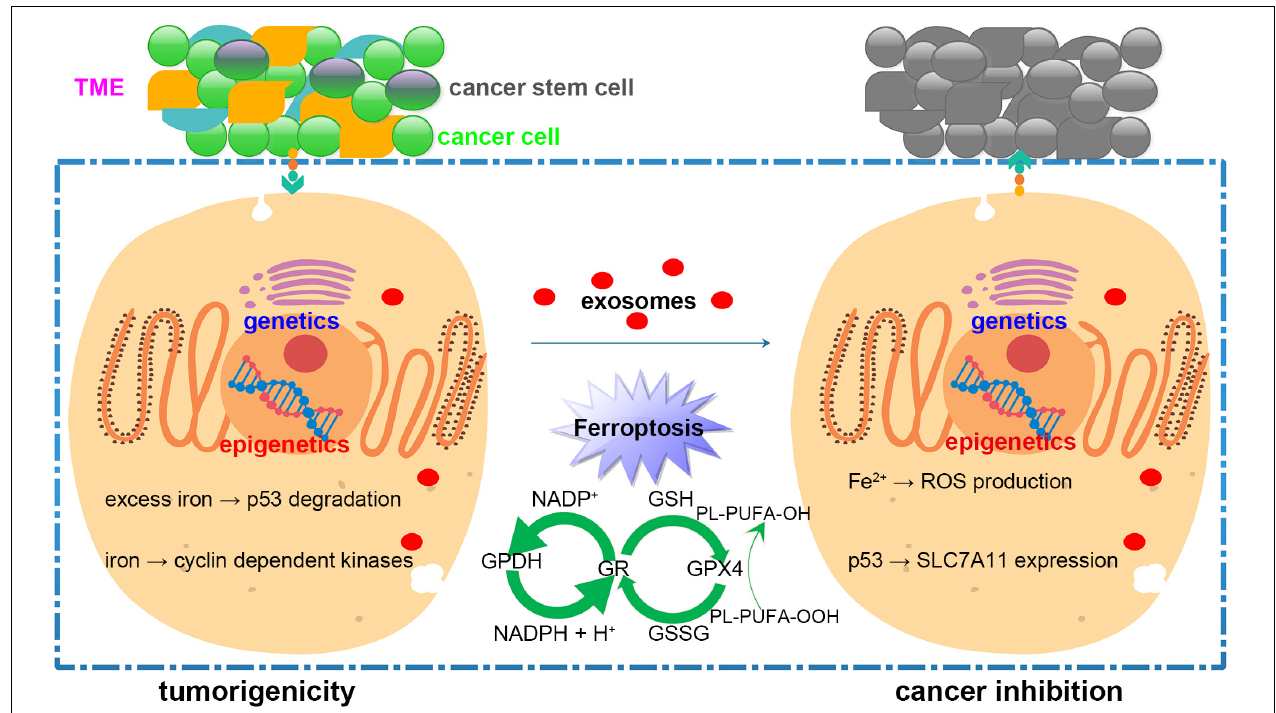
FIGURE 1 | The schematic diagram of modulating ferroptosis in cancer inhibition based on an exosome delivery system. Cancer development and treatment efficacy are impacted by genetic factors, epigenetic modifications, cancer stem cells, and the tumor microenvironment (TME). Ferroptosis is a double-edged sword in cancer survival because it is regulated by different signaling pathways. Cancer treatment could benefit from using an exosome delivery system to control the onset of